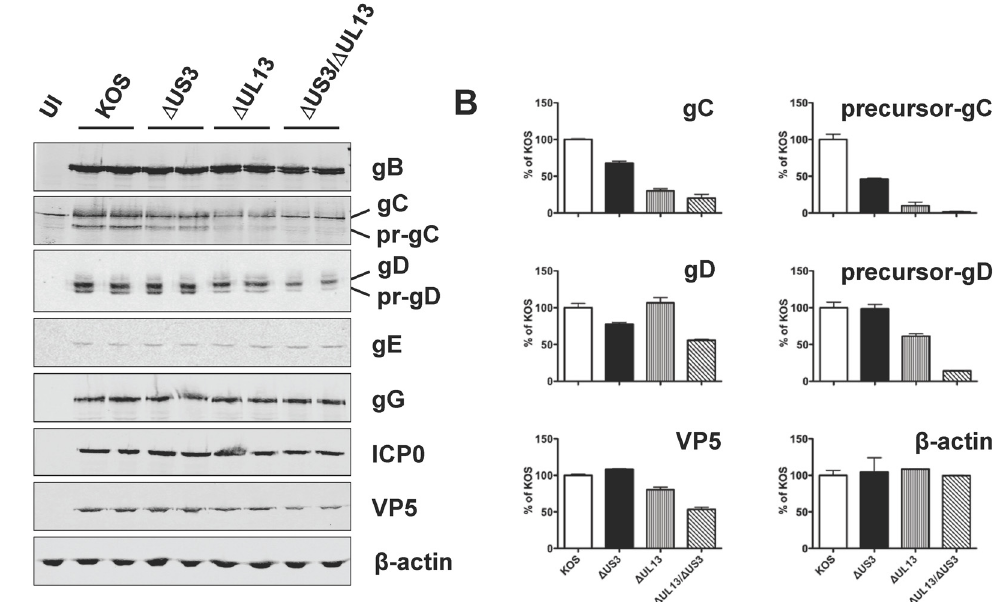
Fig 4. Expression of viral proteins in Vero cells infected with HSV-1 KOS or Δ US3 and Δ UL13 mutants. (A) Vero cells were inoculated in duplicates as described in Fig 3. At 14 hours post-inoculation, whole-cell lysates were prepared and resolved by SDS-PAGE followed by immunoblot analyses with respective antibodies. Each lane contains an amount of lysate equal to 10 5 cells. Levels of β -actin served as a loading control. (B) The relative intensity of signals was quantified by densitometry using ImageJ [106]. Results are shown for proteins whose levels of expression changed substantially as percent change in signal intensity relative to the wild type (HSV-1 KOS) (set to 100) ± SD of the duplicate infections.